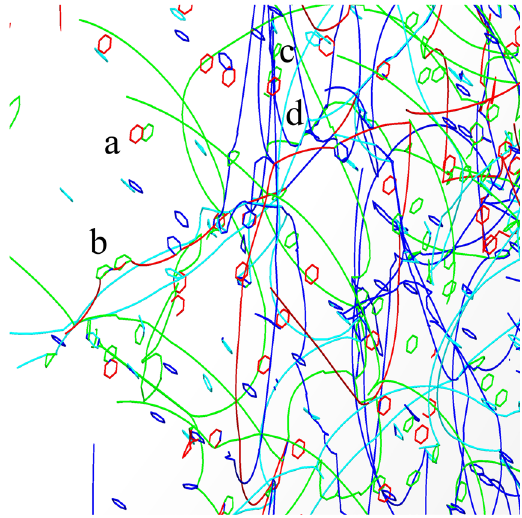
Figure 5. Close-up view of the 3D structure of a dislocation system with glissile dislocation loops at a strain of ε = 0.5%. Different Burgers vectors are indicated with different colors as follows: dark blue = 〈 〉 b . Continuous dislocations and loops evolve into a complex network where they pin to each other. a) Loop dipole b) dislocation pinned by loops c) loops decorating a dislocation d) complex junction. The loop radius is r l = 5 nm.